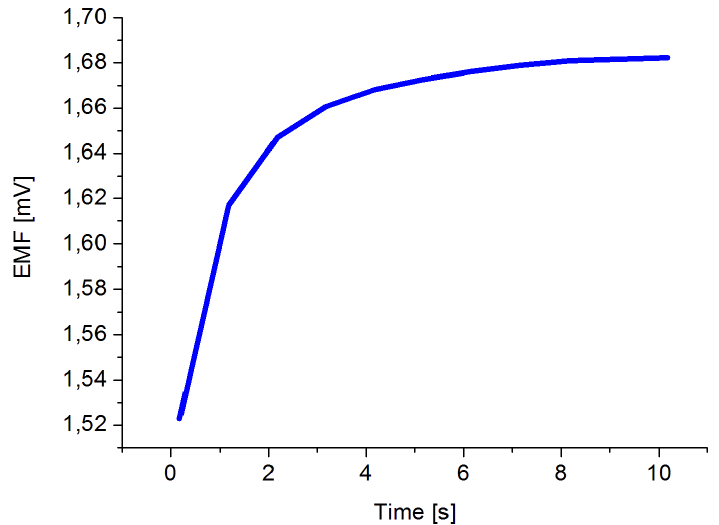
Figure 5. Response time measured in 0.1 mM concentration of